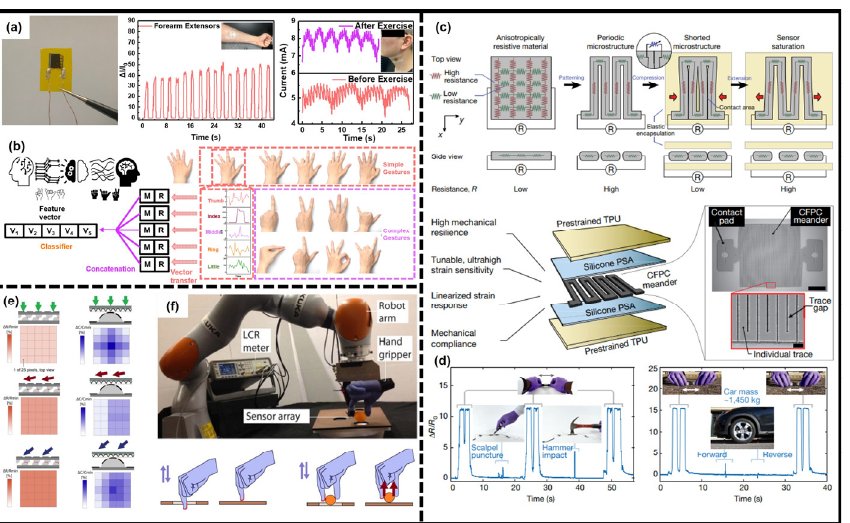
Figure 6. The wearable systems for human movement monitoring. ( a ) Photograph of a dual-microstructure MXene-based piezoresistive pressure sensor and its performance in muscle movement, respiration, and carotid artery monitoring. ( b ) Gesture recognition system based on this wearable sensor. Reproduced with permission from ref. [62]. Copyright 2021 The Royal Society of Chemistry. ( c ) The operation principle of a strain-mediated contact in anisotropically resistive structures (SCARS) sensor ( top ) and schematic illustration of the sensor. ( d ) Demonstration of sensor resilience to punctures ( left ) and high loads ( right ). Reproduced with permission from ref. [205]. Copyright 2020 Nature Publishing Group. ( e ) Schematics showing the comparation of two different structures in detecting the direction of applied pressure. ( f ) Experiments with sensor mounted on a robot arm. Reproduced with permission from ref. [87]. Copyright 2021 American Association for the Advancement of